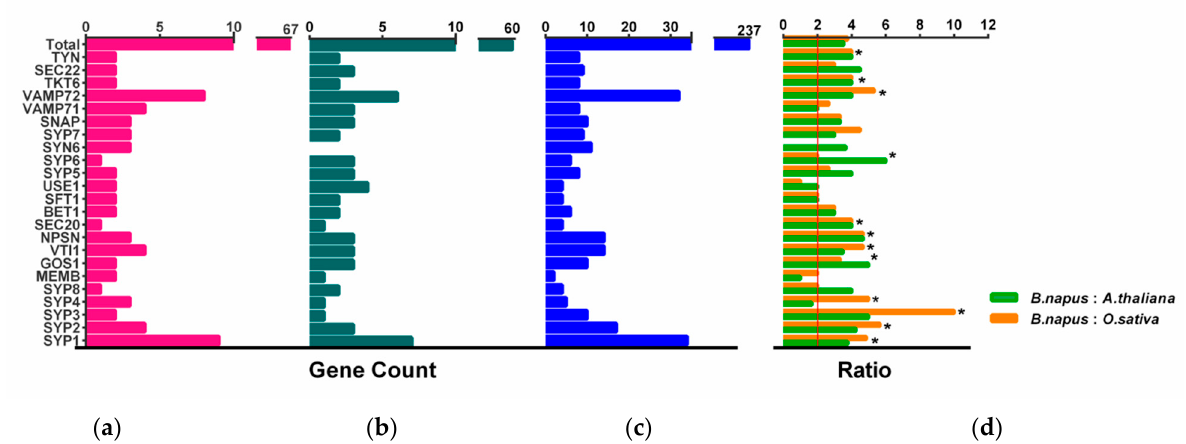
Figure 3. Number of SNARE genes. ( a – c ). The number of SNARE genes identified per SNARE-type subgroup in ( a ) A. thaliana ; ( b ) O. sativa , and ( c ) B. napus [11]. ( d ). The ratio of total SNARE gene numbers to those in all subgroups is shown for B. napus : O. sativa (green) and B. napus : A. thaliana (orange). The expected ratio (2:1) in ( d ) is indicated by a red vertical line, and asterisks mark a significant deviation from the expected value ( χ 2 test, * p < 0.05). Table 1. Homologous gene pairs of SNAREs in B. napus